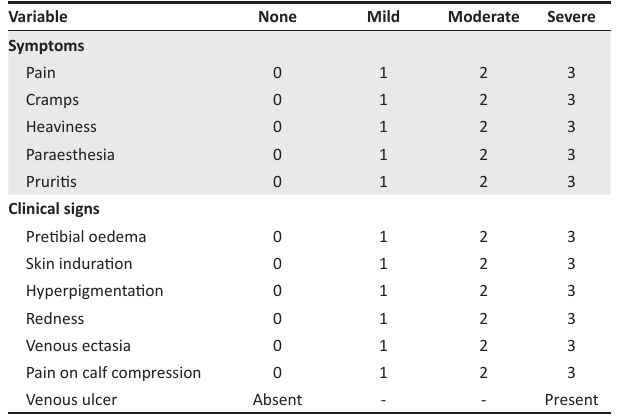
TABLE 2: Villalta scale.